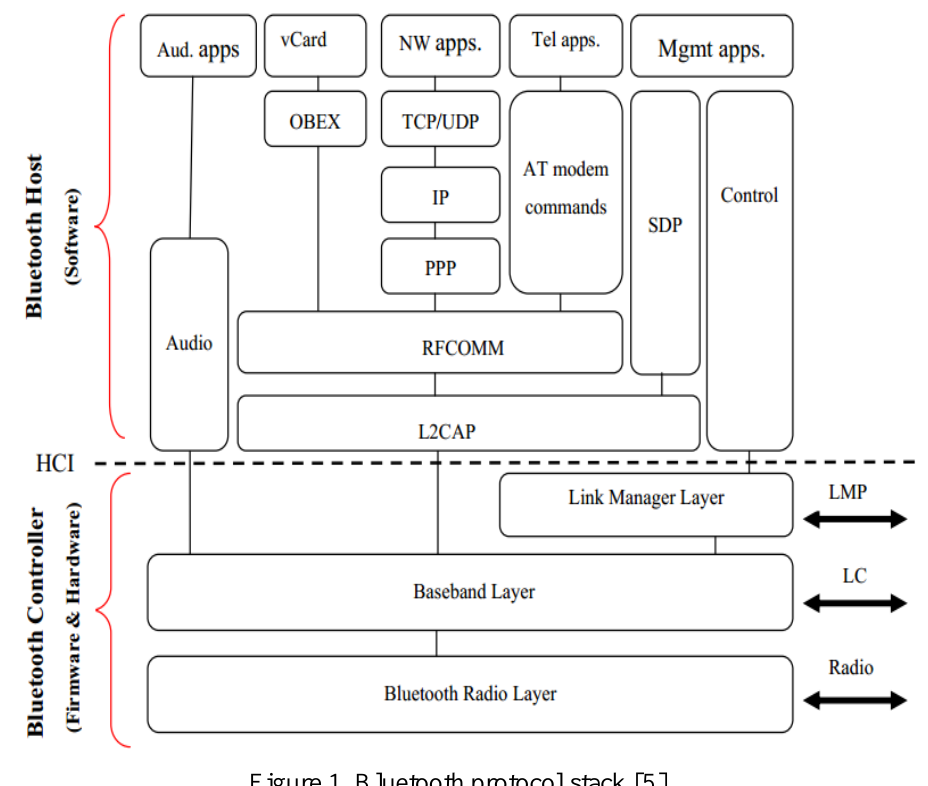
Figure 1. Bluetooth protocol stack